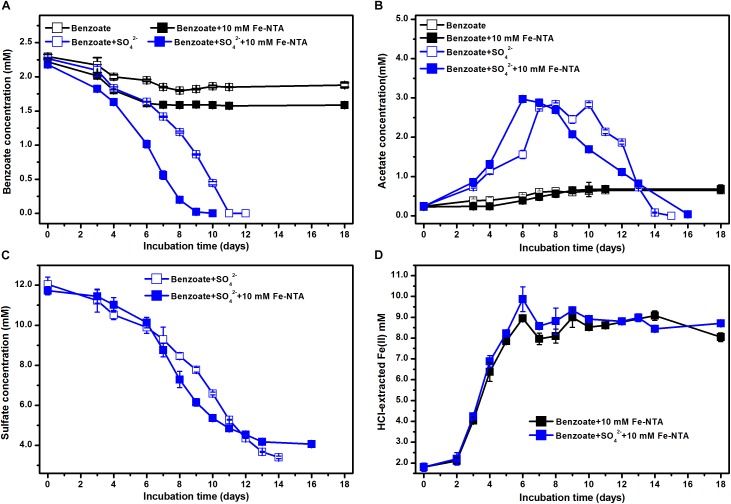
Effect of NTA-Fe(III) addition on benzoate degradation under sulfate-reducing conditions: (A) benzoate degradation; (B) sulfate reduction; (C) acetate concentration; (D) concentrations of Fe(II). Fe-NTA denotes ferric nitrilotriacetate.